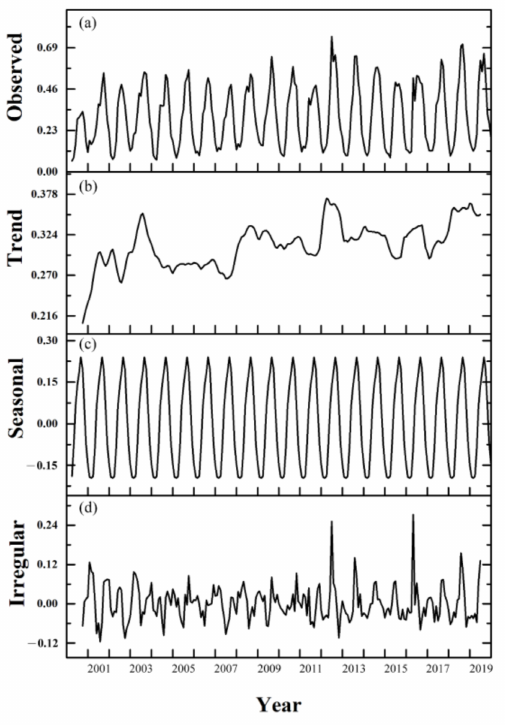
Figure 8. Decomposition result of FVC variation from 2000 to 2019 in Qingyang including ( a ) input time series, ( b ) trend component, ( c ) seasonal cycle, and ( d ) irregular